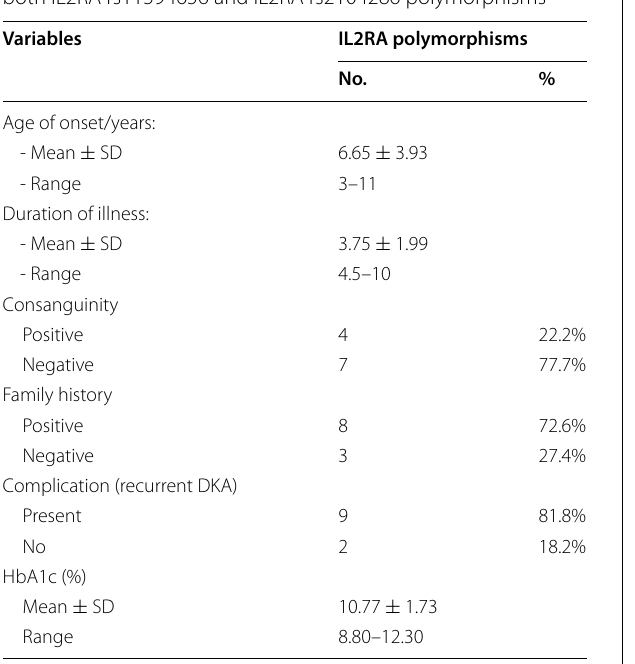
Table 4 Data of diabetic patients have homozygous pattern of both IL2RA rs11594656 and IL2RA rs2104286 polymorphisms